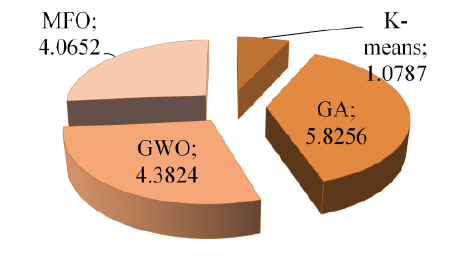
Figure 3. Comparison of computational time of MFO, GWO,